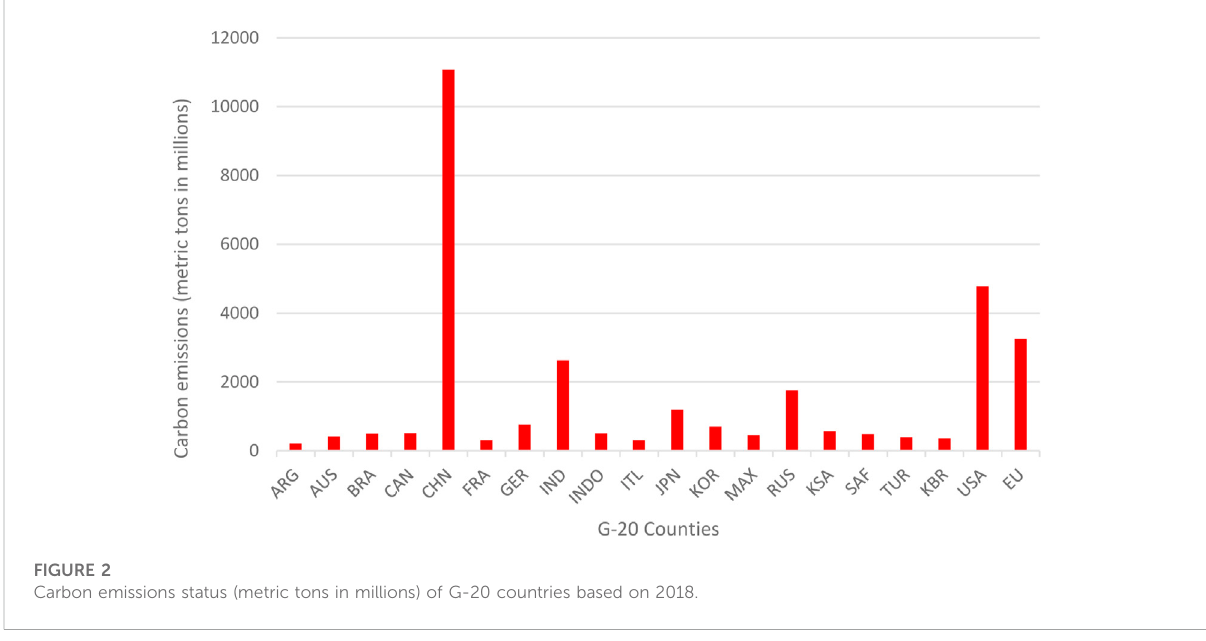
FIGURE 2 Carbon emissions status (metric tons in millions) of G-20 countries based on 2018.